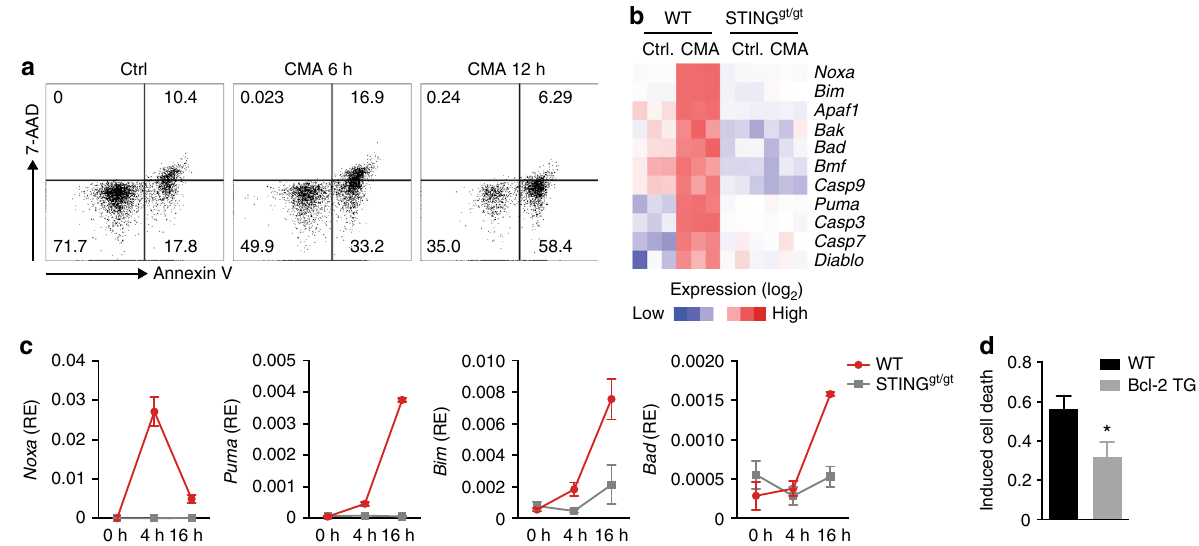
Fig. 3 BH3-only proteins are involved in STING-triggered T cell apoptosis. a Flow cytometric analysis of apoptosis of CD4 + T cells left untreated or treated with 10-carboxymethyl-9-acridanone (CMA) for 6 h and 12 h, assessed by Annexin V and 7-AAD staining. Numbers in quadrants present percentages. b Heat-map of RNA-sequencing analysis. Genes related to cell intrinsic apoptosis with statistically signi fi cant increase in CMA-treated over DMSO-treated CD4 + T cells are shown ( n = 3 biological replicates; P < 0.05; Student ’ s t -test). c T cells from wild-type (WT) or STING gt/gt mice were untreated or stimulated with CMA for 4 h and 16 h. Abundance of mRNAs for the indicated genes was quanti fi ed by RT-qPCR. d CD4 + T cells of the genotypes indicated were treated with DMSO or CMA. After 16 h the percentage of apoptotic cells was assessed by Annexin V and 7-AAD staining. Data are representative of n = 3 independent experiments ( a ) or mean and s.d. of technical replicates of one representative experiment out of n = 3 ( c ) or n = 2 ( d ) independent experiments are shown. * P < 0.05; (Student ’ s t